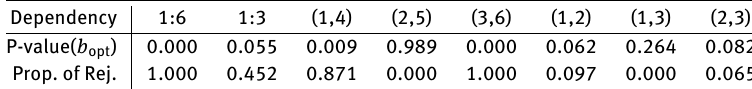
Table 4: Upper row: p-values for the test with b = b opt = (cid:98) n 0.95 /4 (cid:99) = 449 . Lower row: proportion of p-values smaller than 0.05 among all tests with b ∈ {(cid:98) cn (cid:99) : c ∈ 0.10, 0.11, . . . , 0.39, 0.40 } .